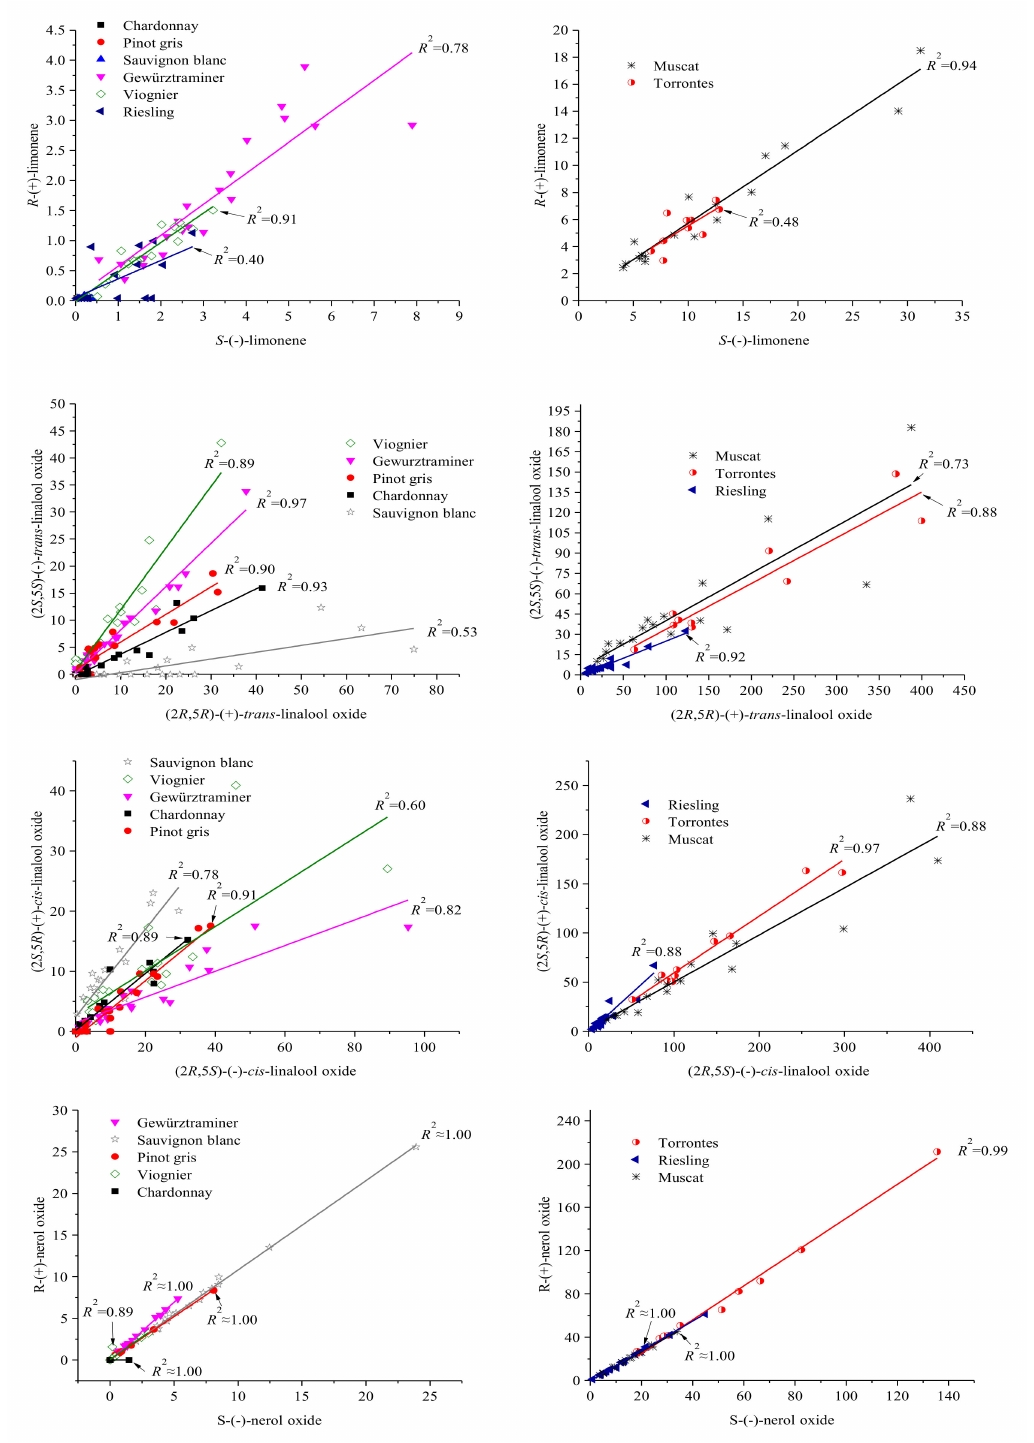
Figure 4. X-Y scatterplots of enantiomer pair concentrations ( µ g/L) in all varietal wines with fitted lines and adjusted R 2